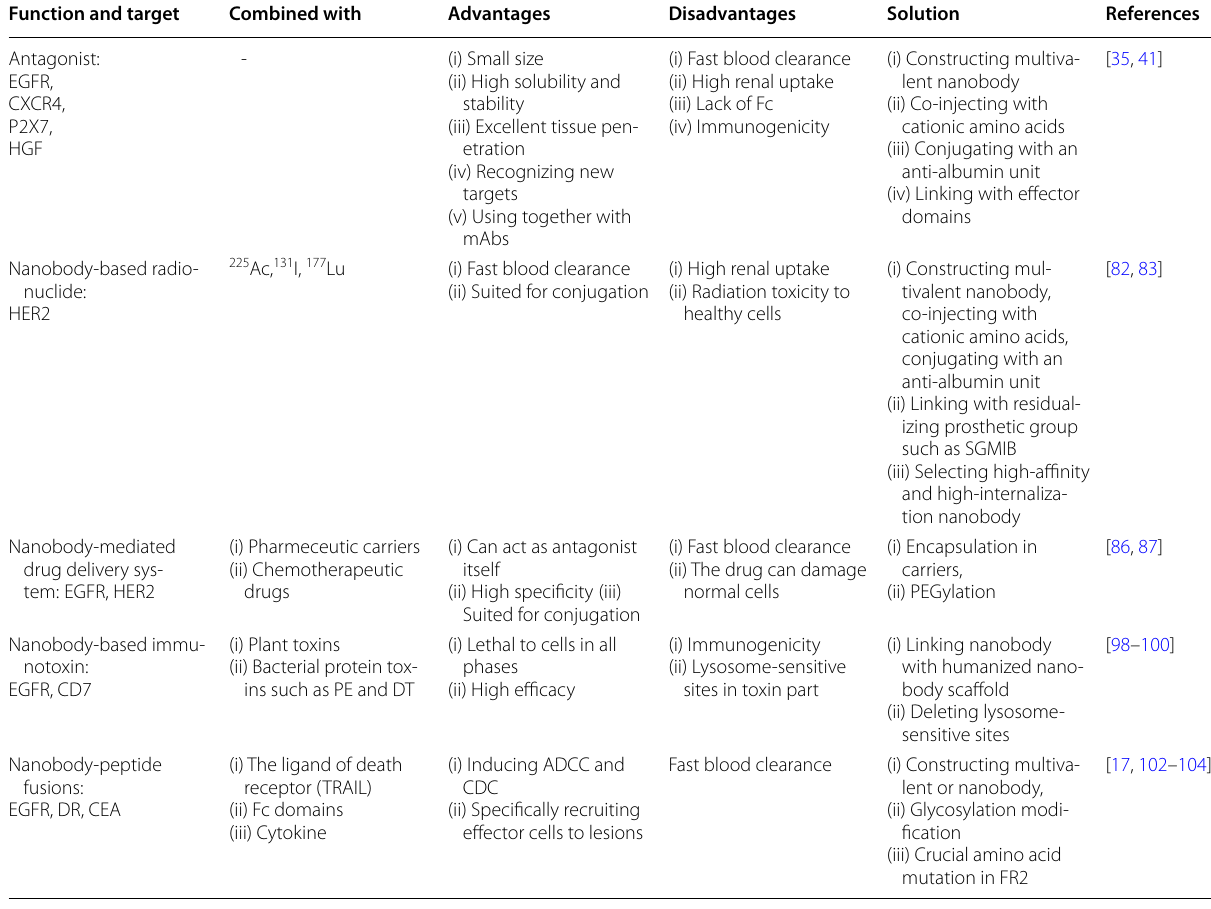
Table 2 Overview on the nanobody-based applications, their advantages and drawbacks, as well as solutions at present Function and